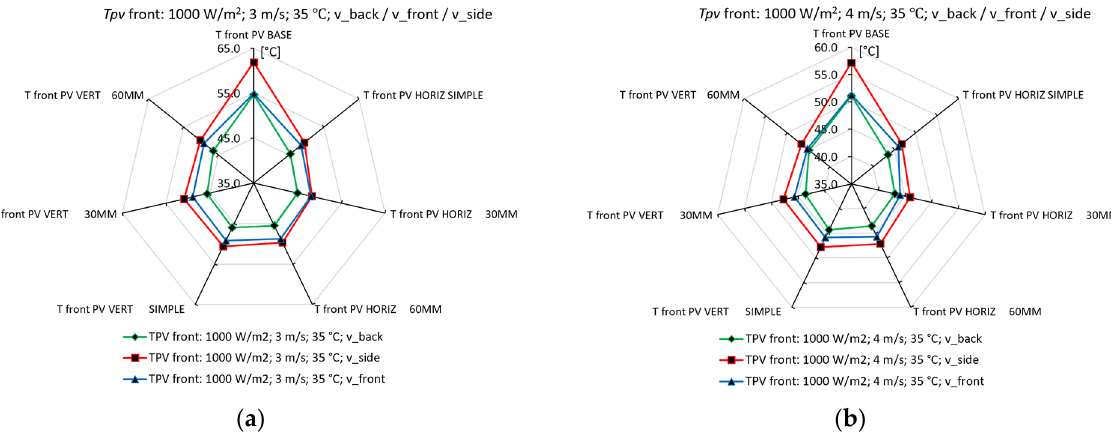
Figure 9. Variation of average operating temperature for ( a ) v air = 3 m/s; ( b ) v air = 4 m/s.